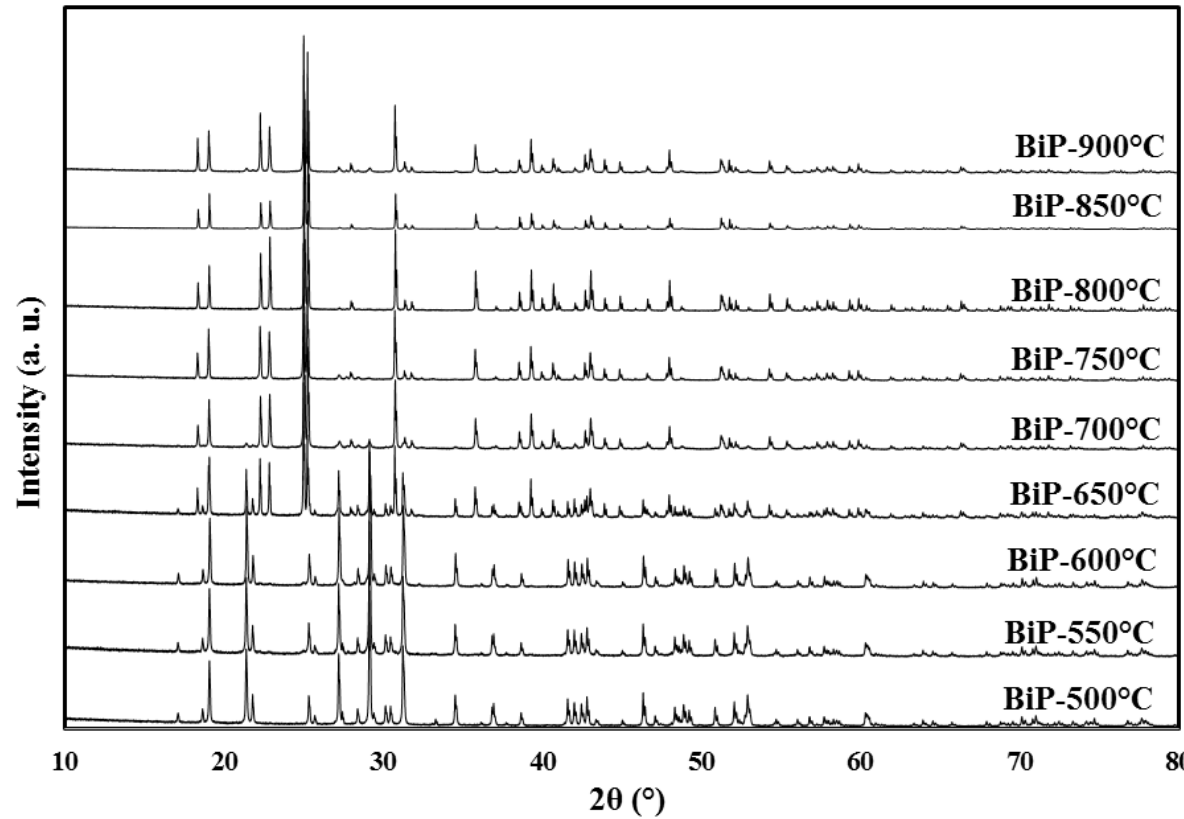
Figure 1. XRD patterns of bismuth phosphate BiPO 4 obtained after different thermal treatments. BiP-500: monoclinic M 1 , at 500 °C; BiP-550 and 600: monoclinic M 1 + traces of monoclinic M 2 , at 550 and 600 °C; BiP-650: monoclinic M 1 + monoclinic M 2 at 650 °C; BiP-800: monoclinic M 2 , at 800 °C; BiP-700, 750, 850 and 900: M 2 + traces of M 1 at 700, 750, 850 and 900.